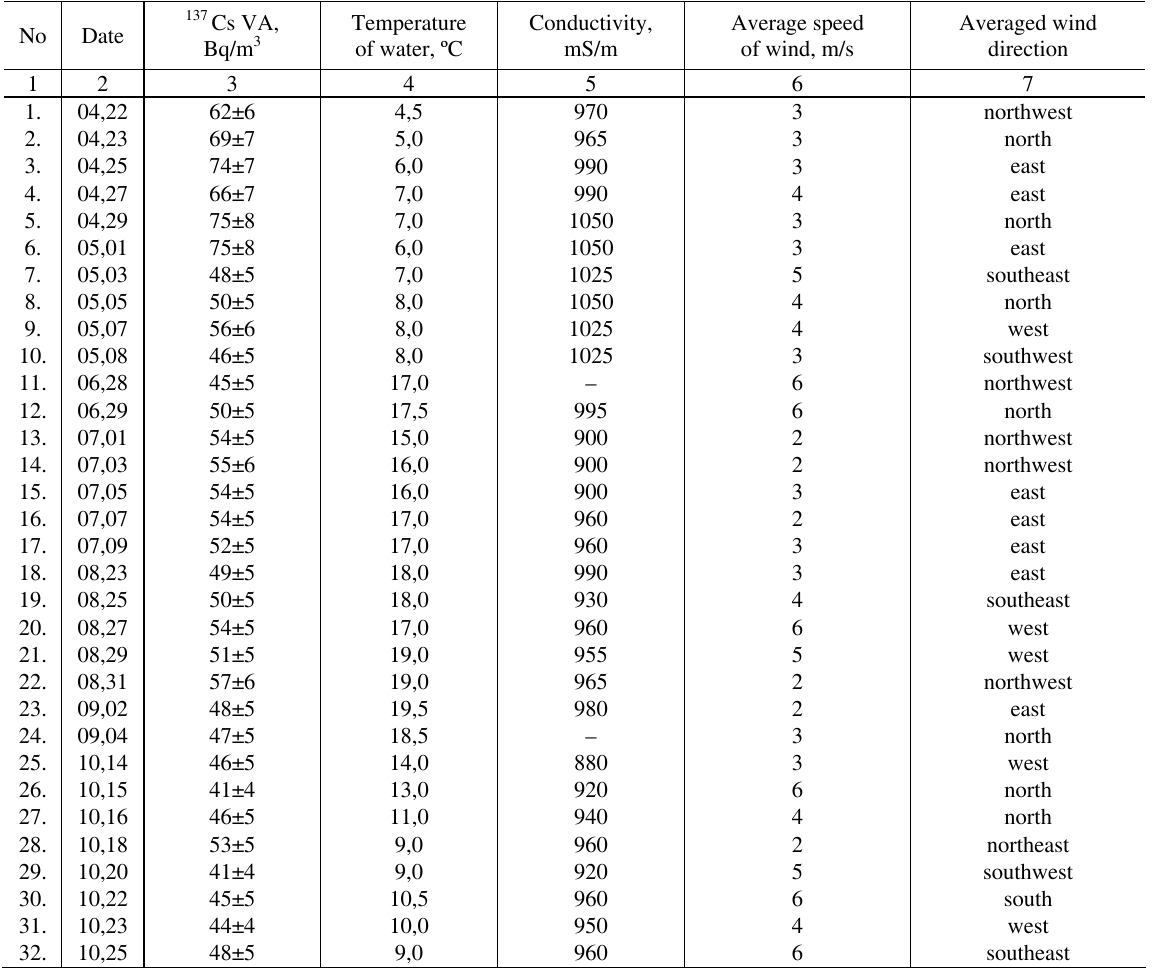
Fig 2. Average monthly values of radionuclide 137 Cs VA in the coastal waters of the Baltic Sea Table 3. Volumetric activity of radionuclide 137 Cs (Bq/m 3 ) and some hydrometeorological parameters of coastal waters of the Baltic Sea (Juodkrant ė ) in